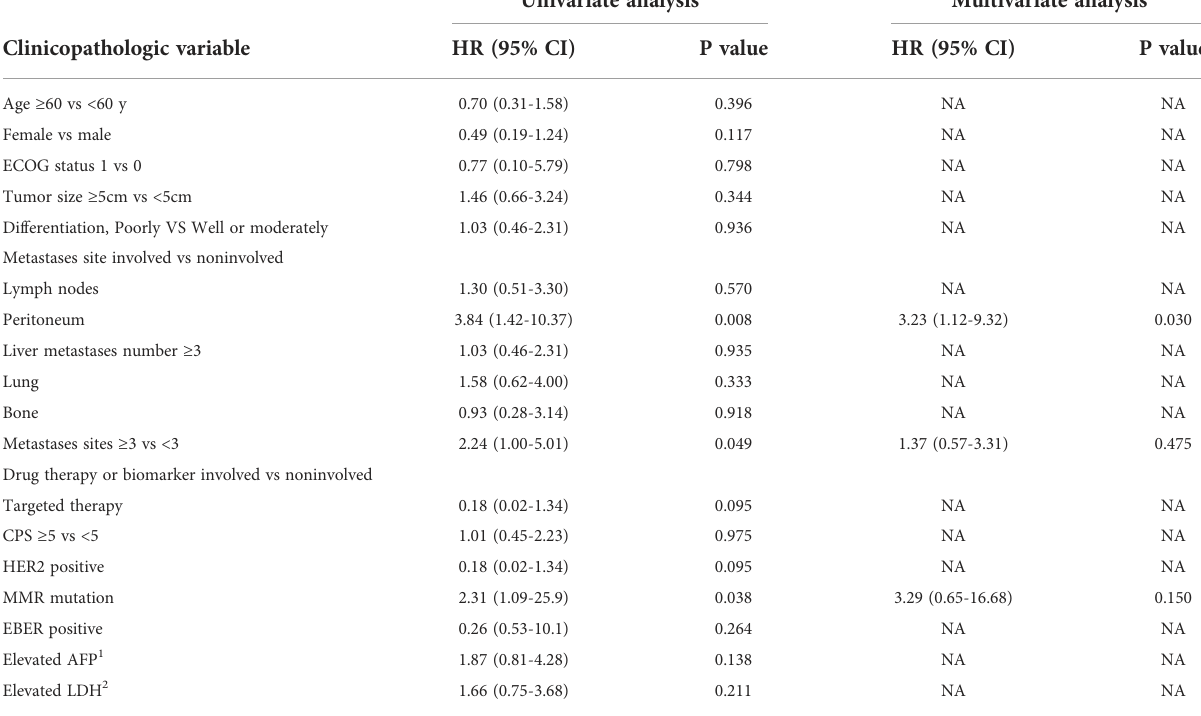
TABLE 3 PFS and association with clinicopathologic characteristics using cox regression in I-LM(+)